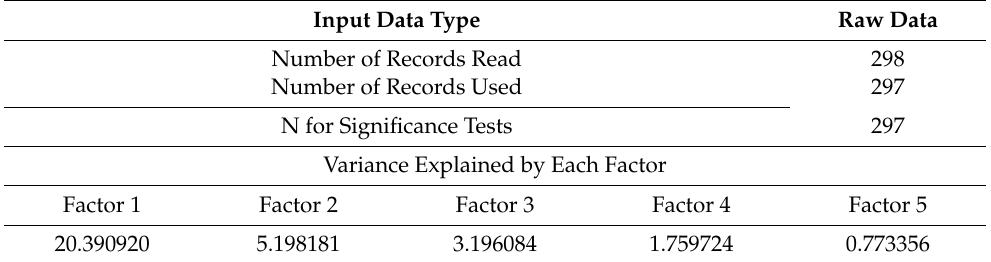
Table 4. The table presenting the analysis info for facto analysis at site Liito-oravankatu.